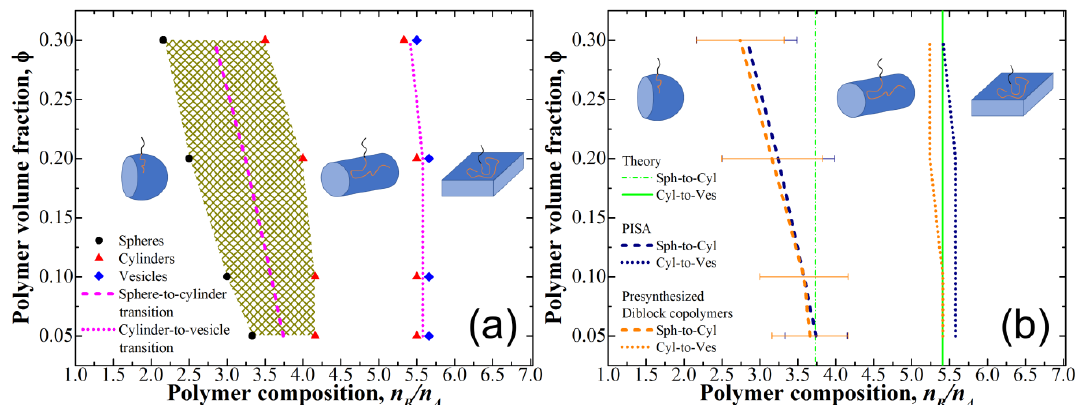
Figure 3. ( a ) Phase diagram for polymerization-induced self-assembly. Only the points closest to the transitions are shown. The shaded area denotes the transition region between the spheres and cylinders; ( b ) Comparison of the transition lines obtained for monodisperse presynthesized diblock-copolymers and polymerization-induced self-assembly (PISA) as well as predictions of the analytical theory [26].